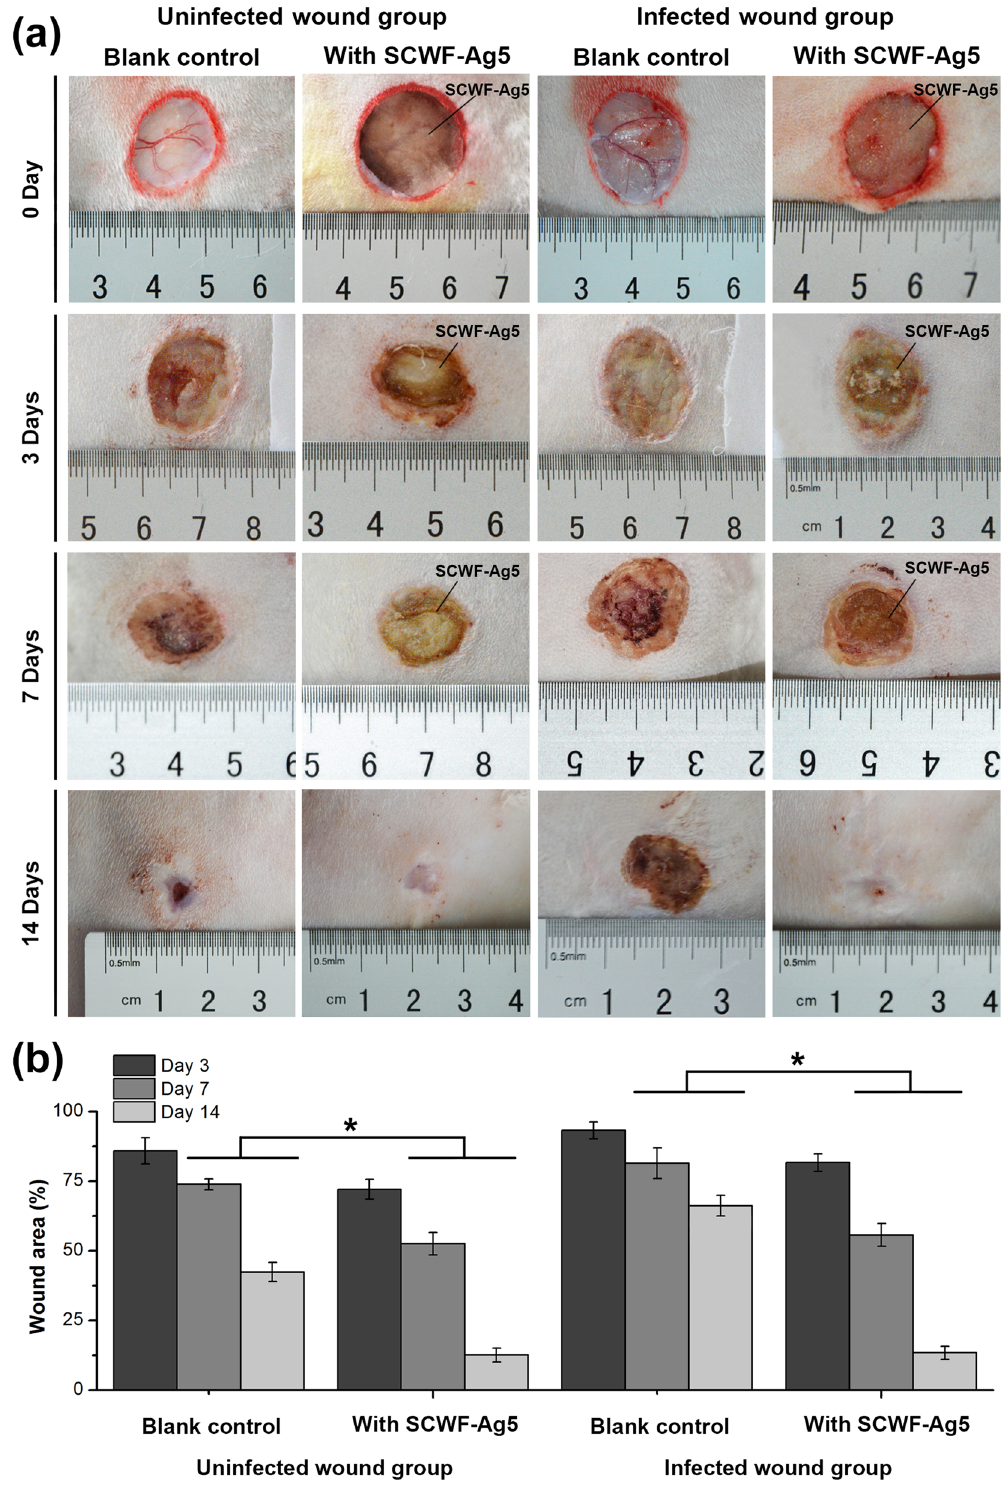
Figure 7. SCWF-Ag5 enhances wound contracture. ( a ) Visual observation of surface healing in the uninfected- and infected-wound groups. SCWF-Ag5 enhanced wound contracture. All the images in this Figure show the progression of wound healing for the same animal. ( b ) Quantitative evaluation of wound healing by measuring wound area when untreated and treated with SCWF-Ag5. Values are the means ± SD for each group (n = 3, * P <